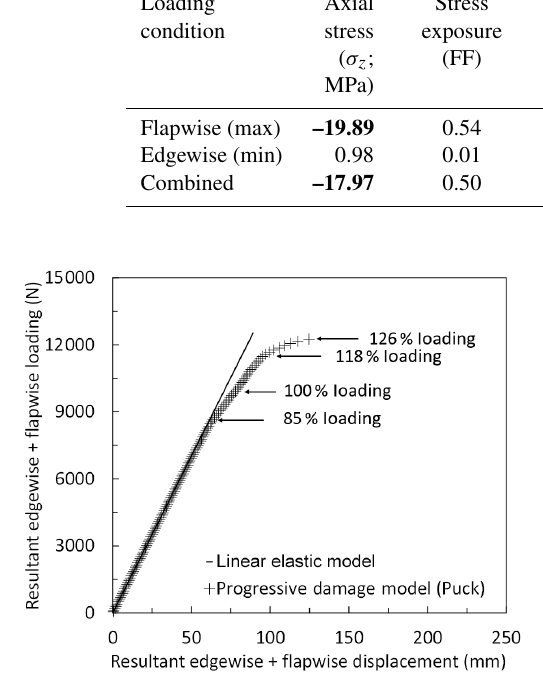
Figure 25. Load–displacement curves of the blade using the linear elastic model and progressive damage model (Puck) under com- bined extreme edgewise (min) and extreme flapwise (max) loading.